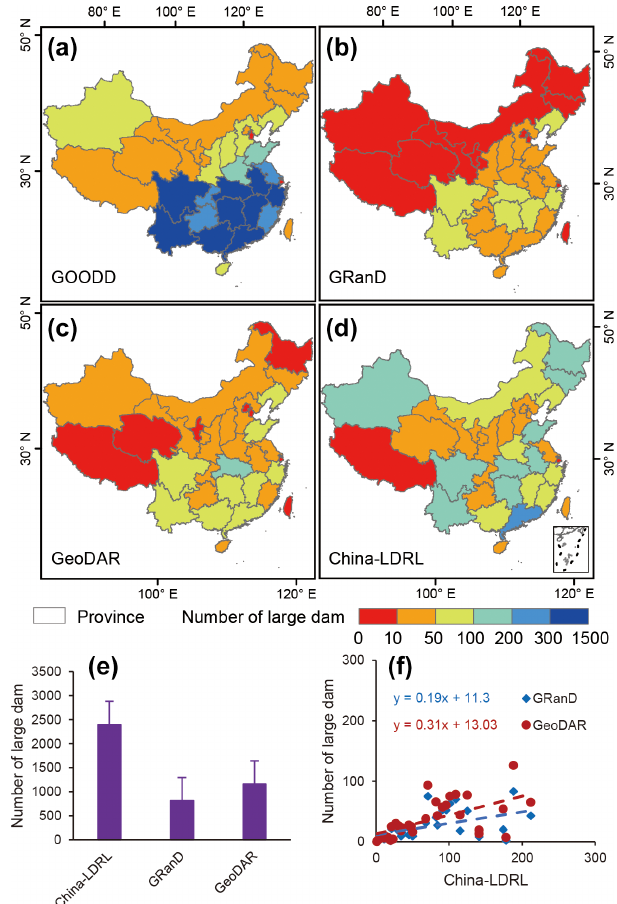
Figure 9. Numbers of large dams (with reservoir area > 1km 2 ) of different datasets. (a) Large dam number in the GOODD dataset; (b) large dam number in the GRanD dataset; (c) large dam number in the GeoDAR dataset; (d) large dam number in the China-LDRL dataset; (e) total numbers of large dam from different datasets in China; and (f) the relationships of large dam numbers between China-LDRL, GRand, and GeoDAR